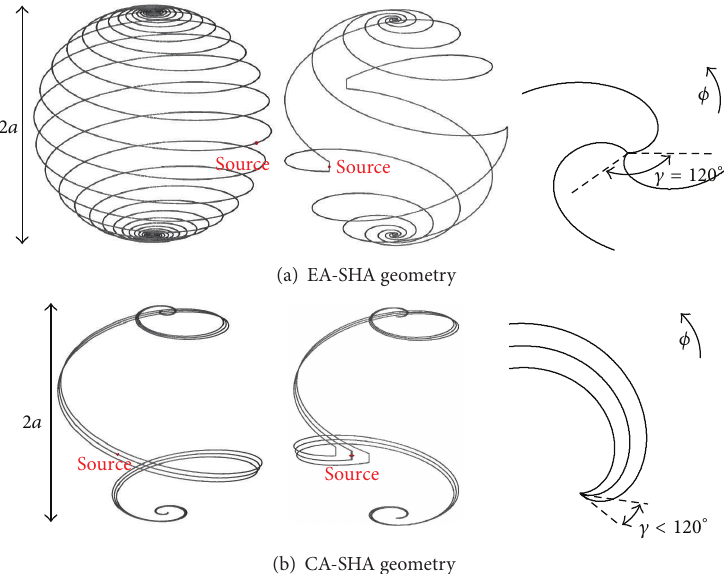
Figure 4: Examples of three-arm SHA geometries, from left to right: (a) EASS-SHA, EARS-SHA, EA spirals with difference angle 𝛾 and (b) CASS-SHA, CARS-SHA, CA spirals with difference angle 𝛾 .